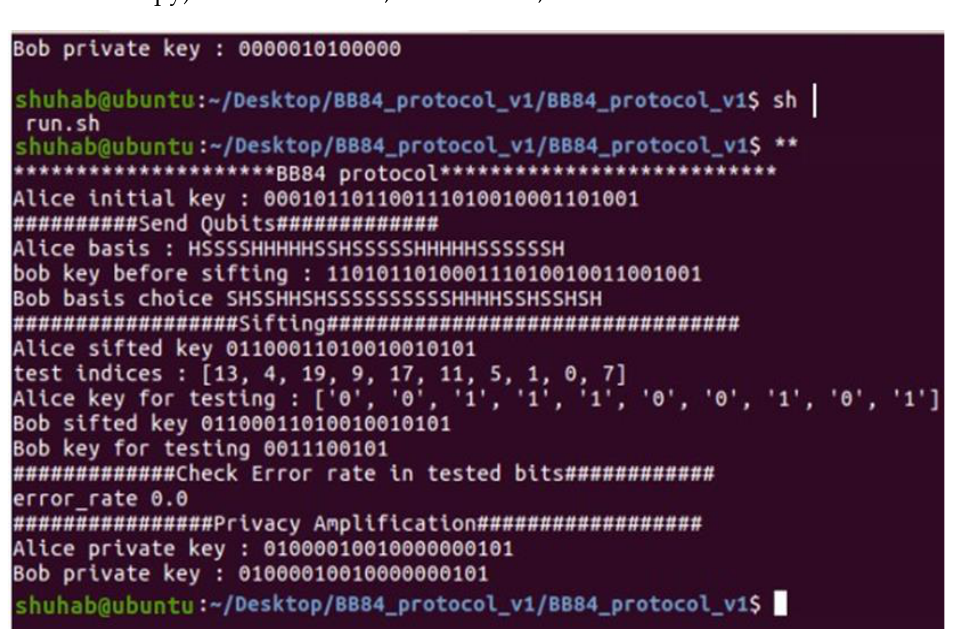
Figure 4. Execution of the Sender.py.